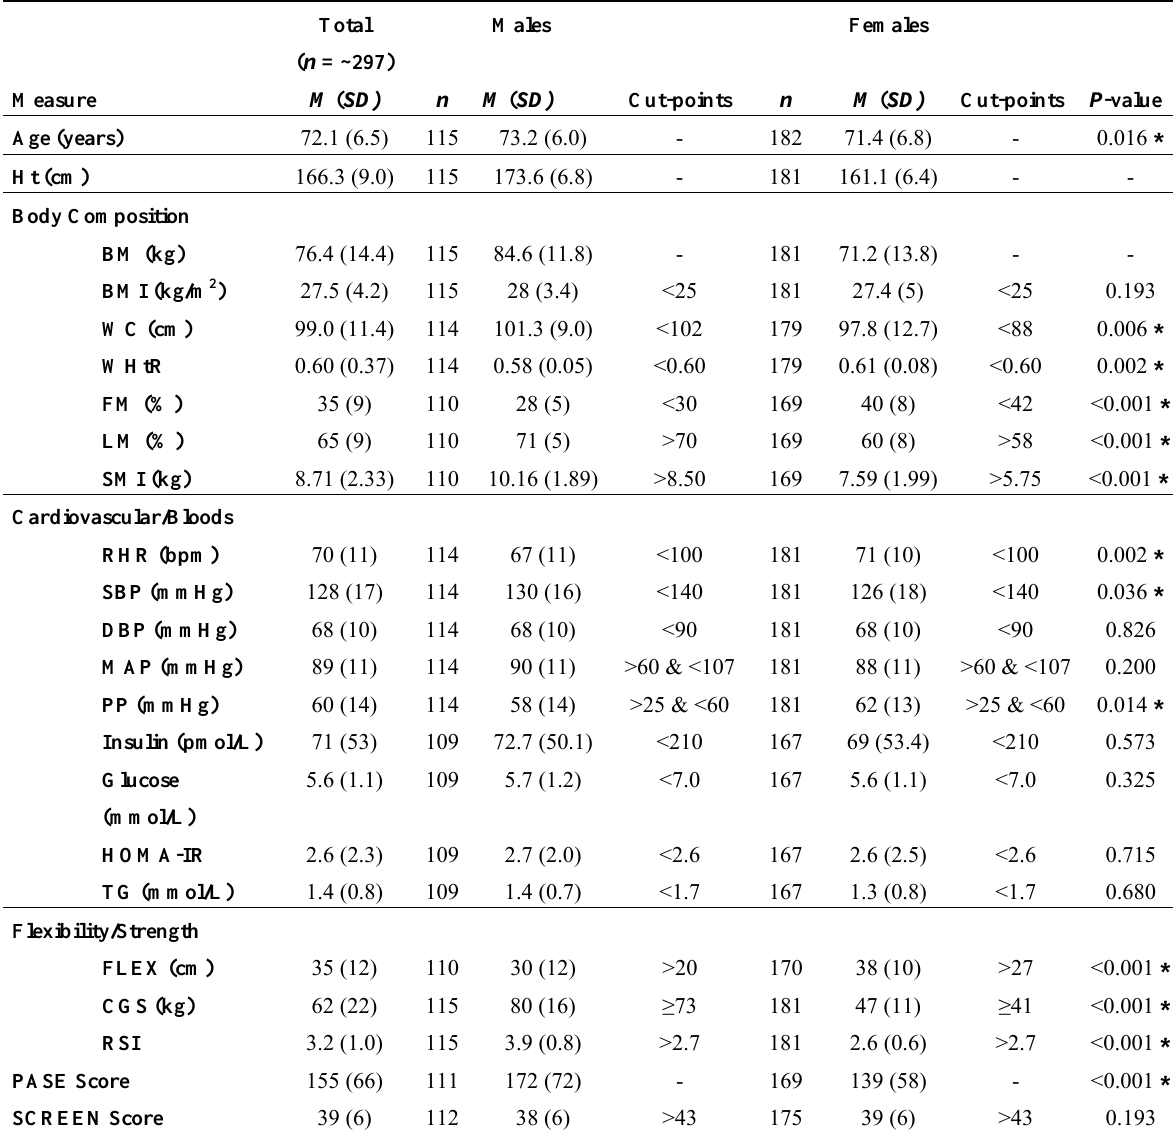
Table 2. Participant characteristics, body composition, cardiovascular/bloods, flexibility/strength, and PASE and SCREEN scores, and healthy cut-points of older community-dwelling older